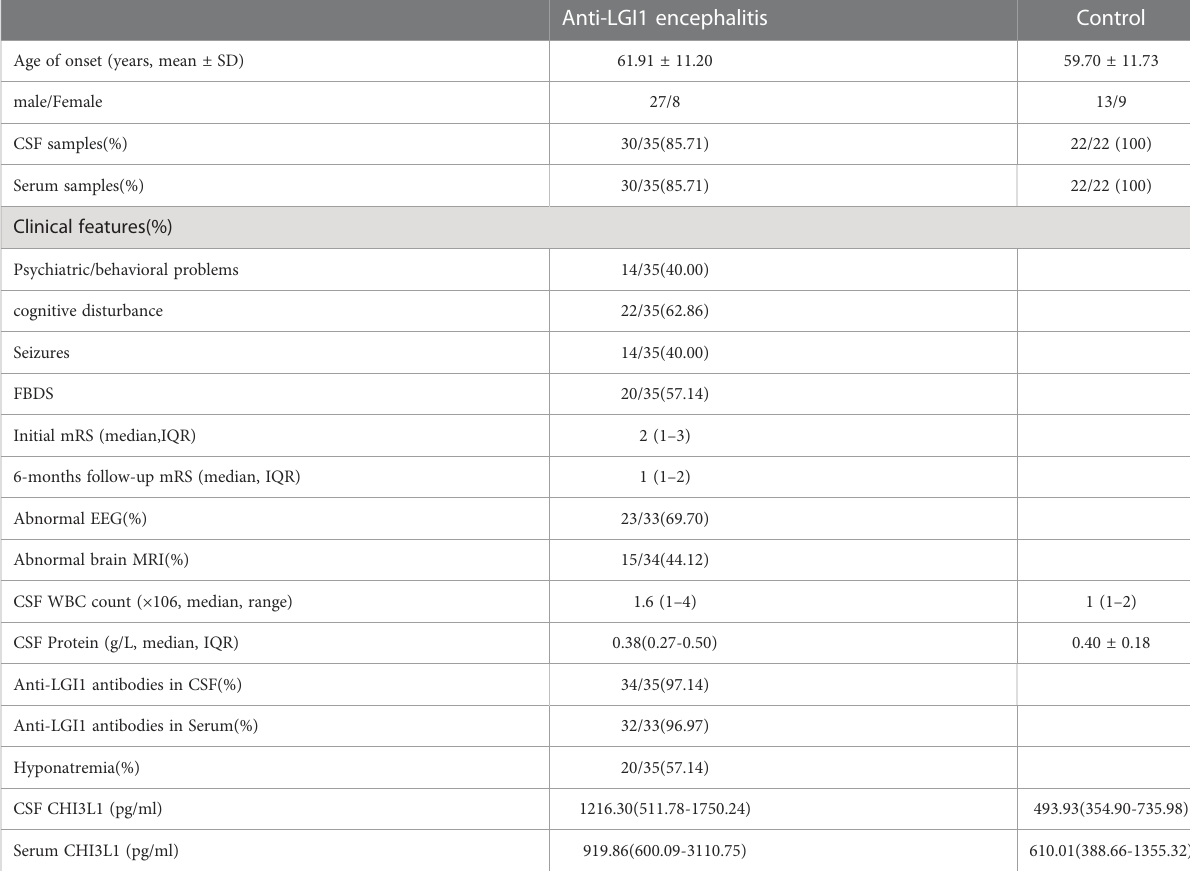
TABLE 1 Clinical data and laboratory fi ndings of anti-LGI1 encephalitis patients (n=35)and controls